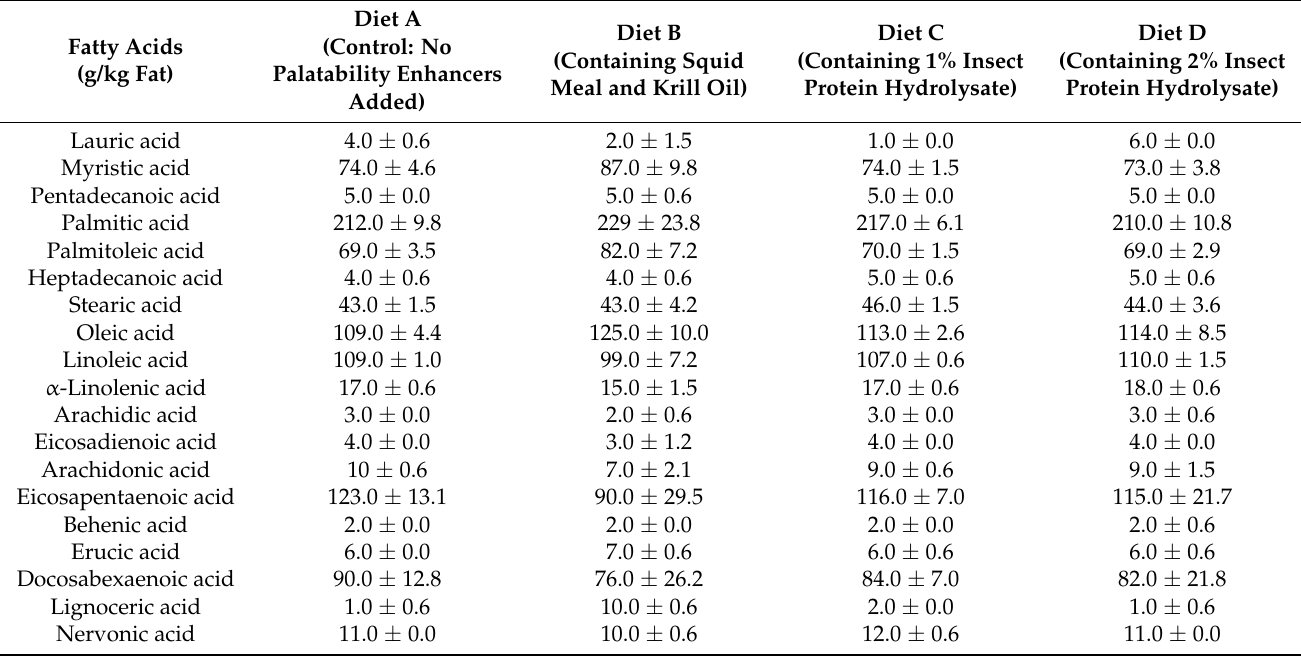
Table 3. Fatty acid composition of four diets used in the